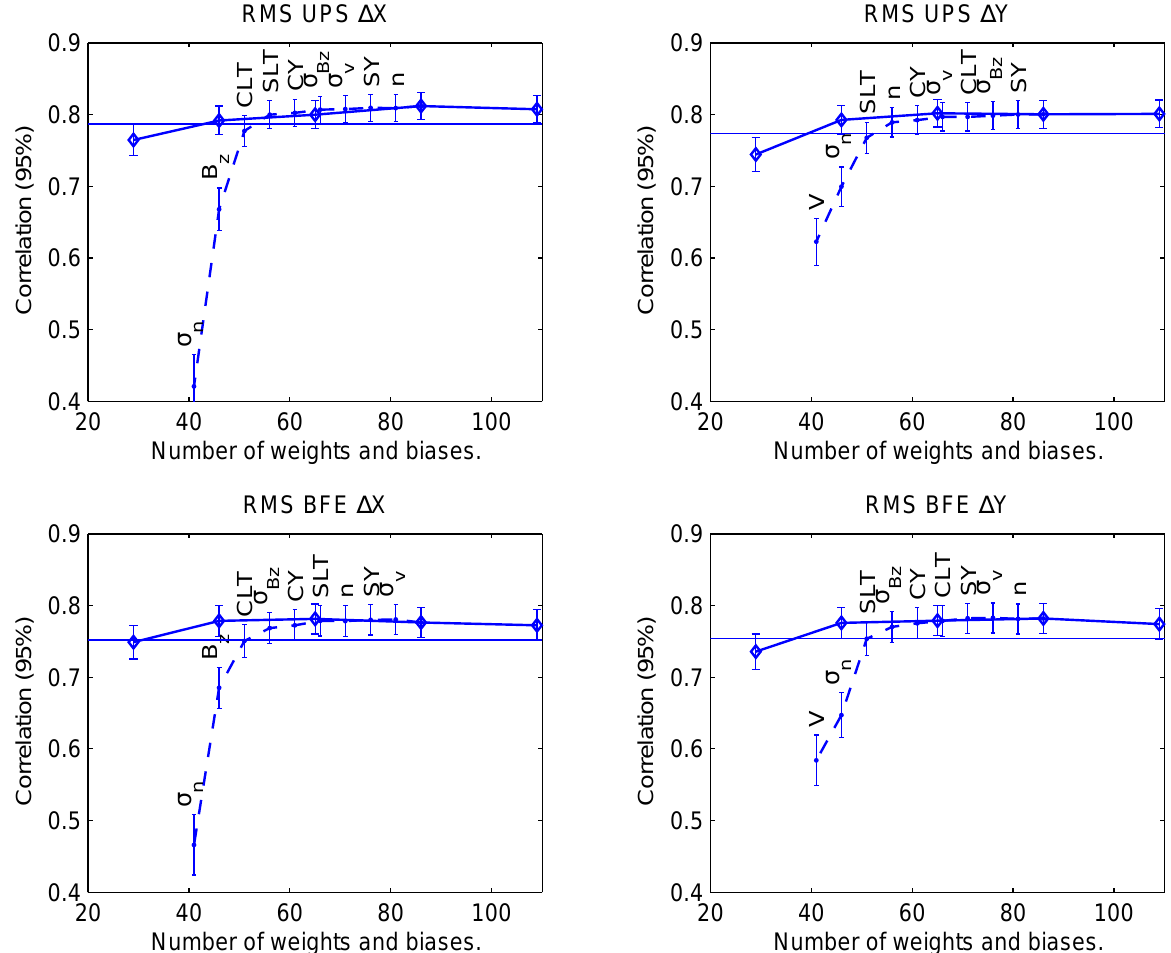
Number of weights and biases. Fig. 3. The figure shows the correlation coefficients C( log r, log r) for networks with different numbers of weights and biases. The plots show the results for the models, predicting the 10-min root-mean-square (RMS) 1X (RMS UPS 1X ) and RMS 1Y (RMS UPS 1Y ) at Uppsala, and RMS 1X (RMS BFE 1X ) and 1Y (RMS BFE 1Y ) at Brorfelde. The error bars indicate the 95% confidence levels. The horizontal line in each plot indicates the level at which the correlation is significantly lower than the highest correlation. The solid curve connected with diamonds corresponds to the fully connected networks with 2, 3, 4, 5 and 6 hidden units. The labels along the dashed curve show which input that has been removed. The labels have the following meaning: solar wind magnetic field z-component ( B z ), proton number density (n), and velocity (V); standard deviations of B z ( σ Bz ), n ( σ n ), and V ( σ V ); sine (SY) and cosine (CY) of the year; sine (SLT) and cosine (CLT) of local